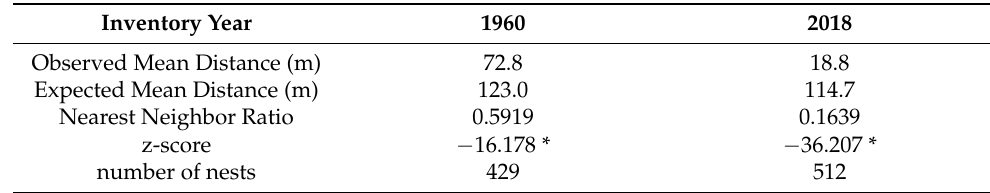
Figure A3. Distribution of RWA (n = 429) from 1960, in different types of forest stand from original Poieni map. Table A1. Nearest Neighbor Analysis of RWA in 1960 and 2018, each calculated for the whole study areas as